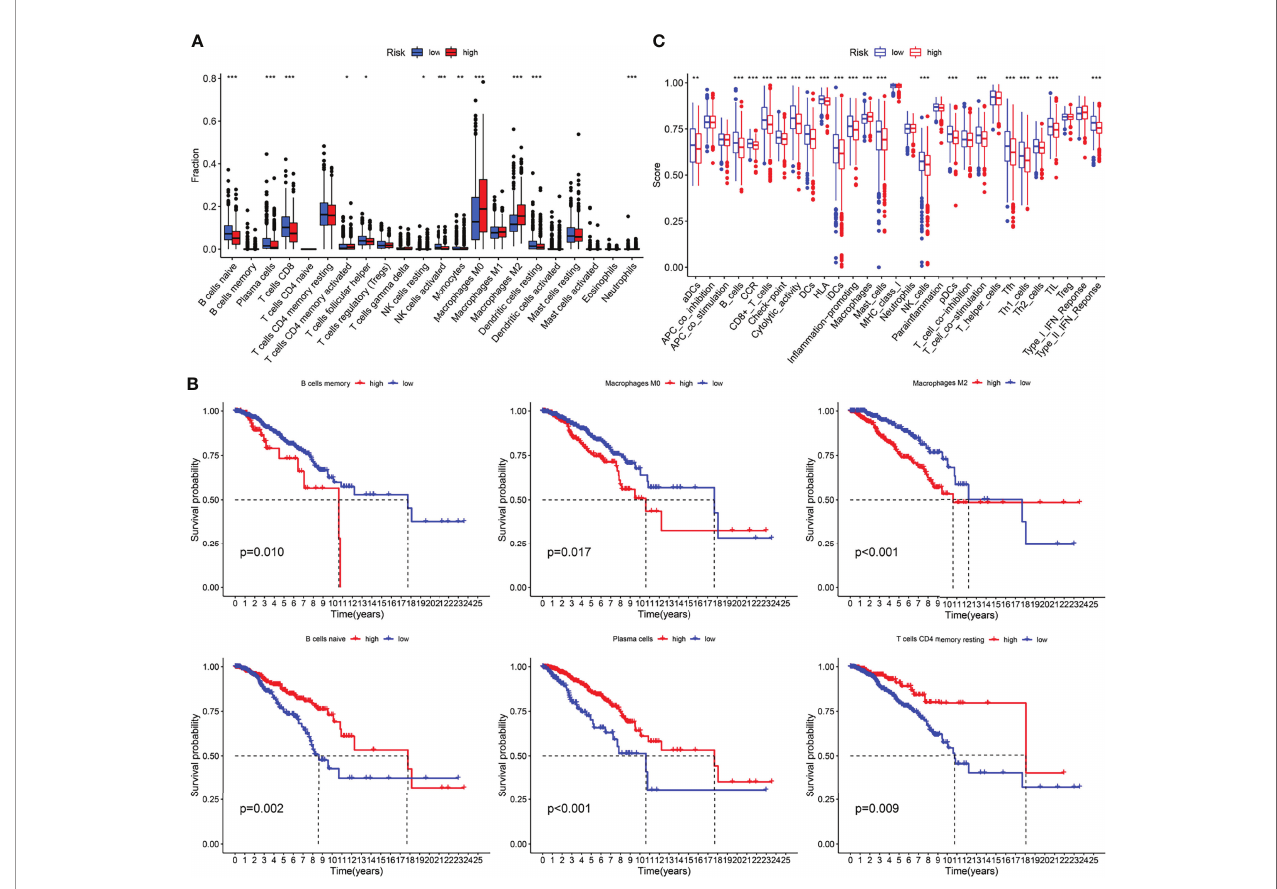
FIGURE 6 | Immune characteristics analysis of different IRGPI subgroups. (A) The proportions of immune in fi ltration cells in different IRGPI subgroups. (B) Kaplan- meier survival curve of differential immune cells ( P < 0.05). (C) The difference immune cell function in different IRGPI subgroups. * P < 0.05, ** P < 0.01, *** P <